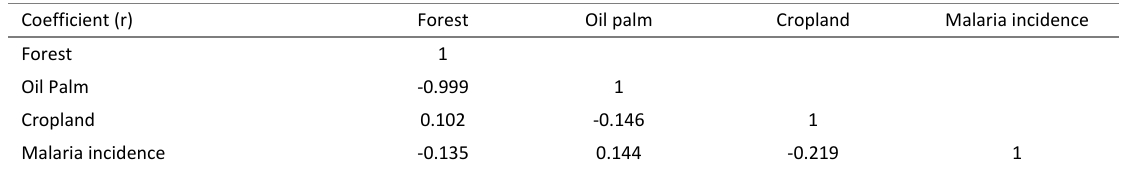
Table 4: Correlation of land cover changes and malaria incidence rate in selected districts of Coefficient (r) Forest Oil palm